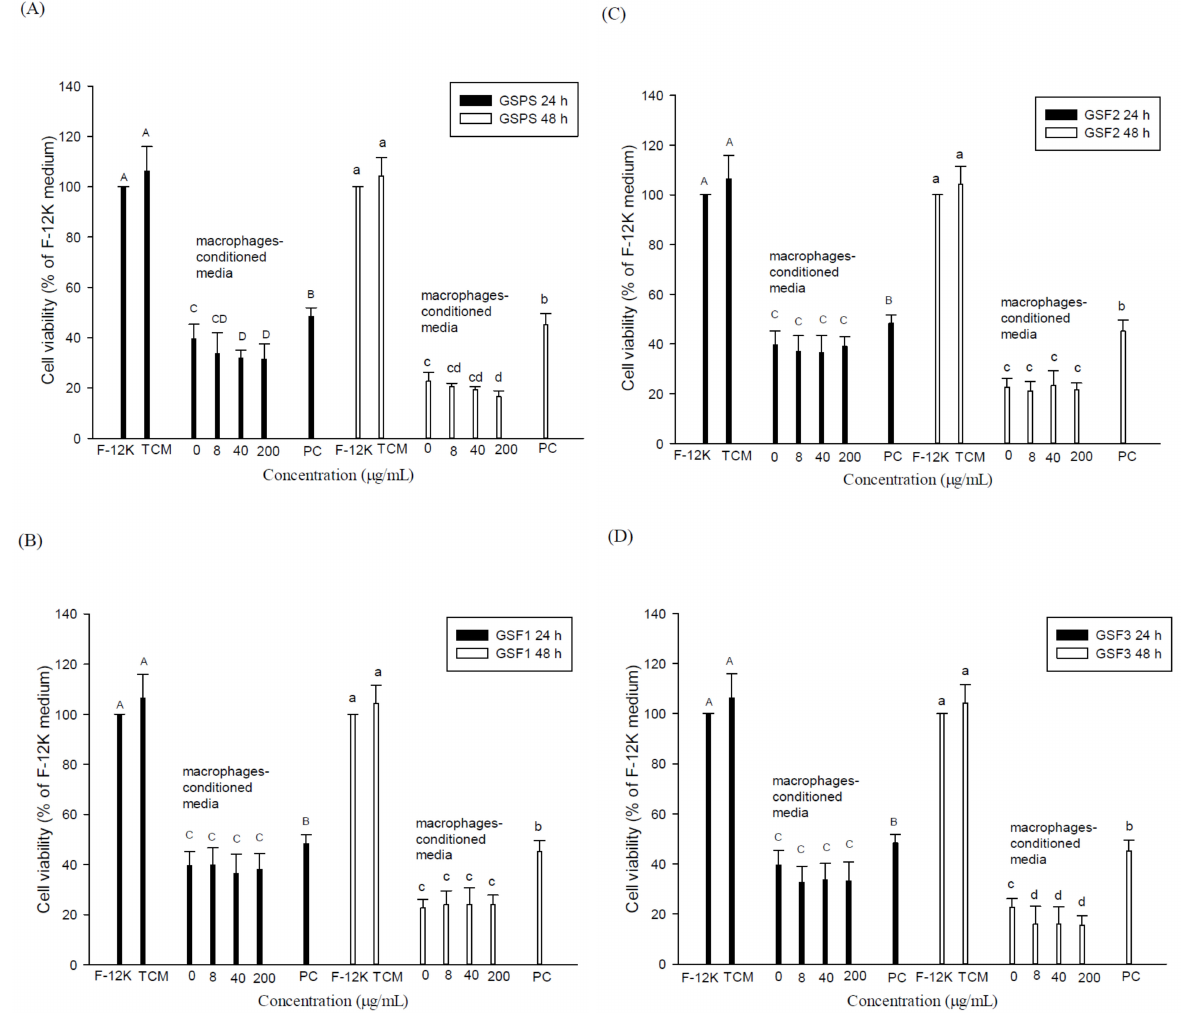
Figure 4. Effects of indirect treatments with macrophage conditioned media (MCM) cultured with guava seed polysaccharide (GSPS) ( A ), GSF1 ( B ), GSF2 ( C ), and GSF3 ( D ) on PC-3 cell growth. Cells (2 × 10 5 cells/mL) were treated with MCM for 24 and 48 h, respectively. Values are means ± SD (n = 6 biological determinations). Bars in the same plot at the same incubation time not sharing a common letter are significantly different ( p < 0.05) from each other, assayed by one-way ANOVA, followed by Duncan’s multiple range test. MCM, conditioned media of peritoneal macrophages cultured with polysaccharide fractions at different concentrations; PC, positive control (paclitaxel at 2.5 µ